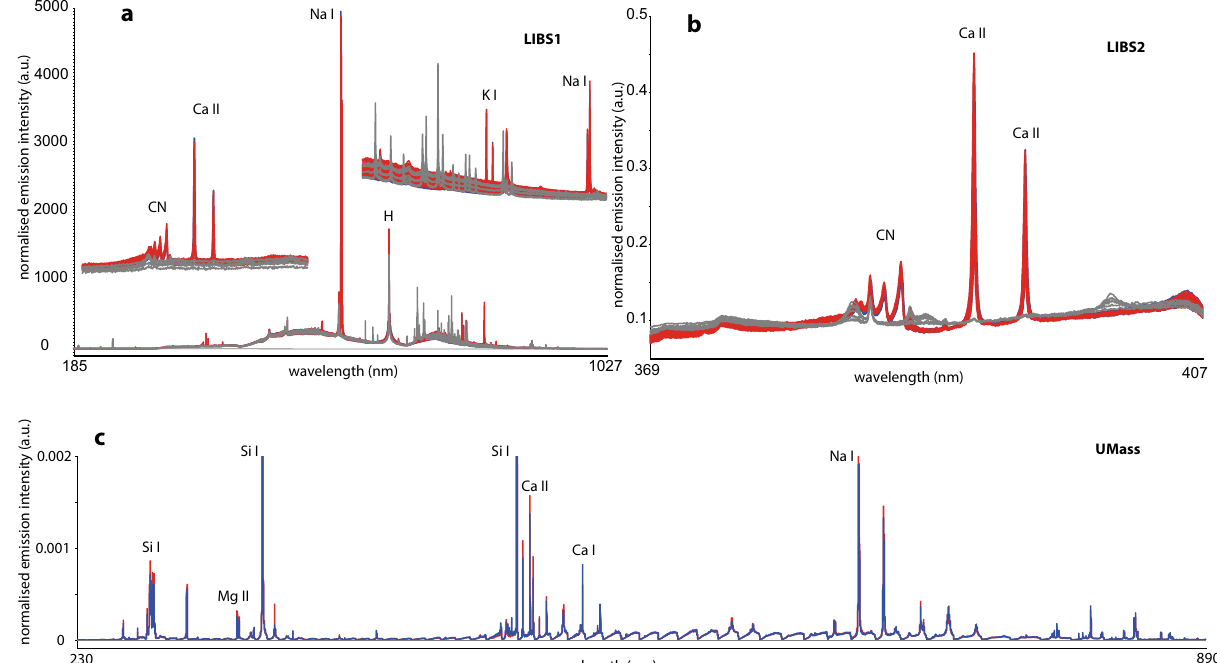
Figure 2. LIBS spectra from LIBS 1, LIBS 2 and UMass. Cumulative and averaged (UMass) spectra of 100 shots. Red are positive samples; blue are negative samples. LIBS 1 and LIBS 2 were deposited on PDVF filters (grey), UMass samples were deposited on Si wafers. All spectra are normalised to total